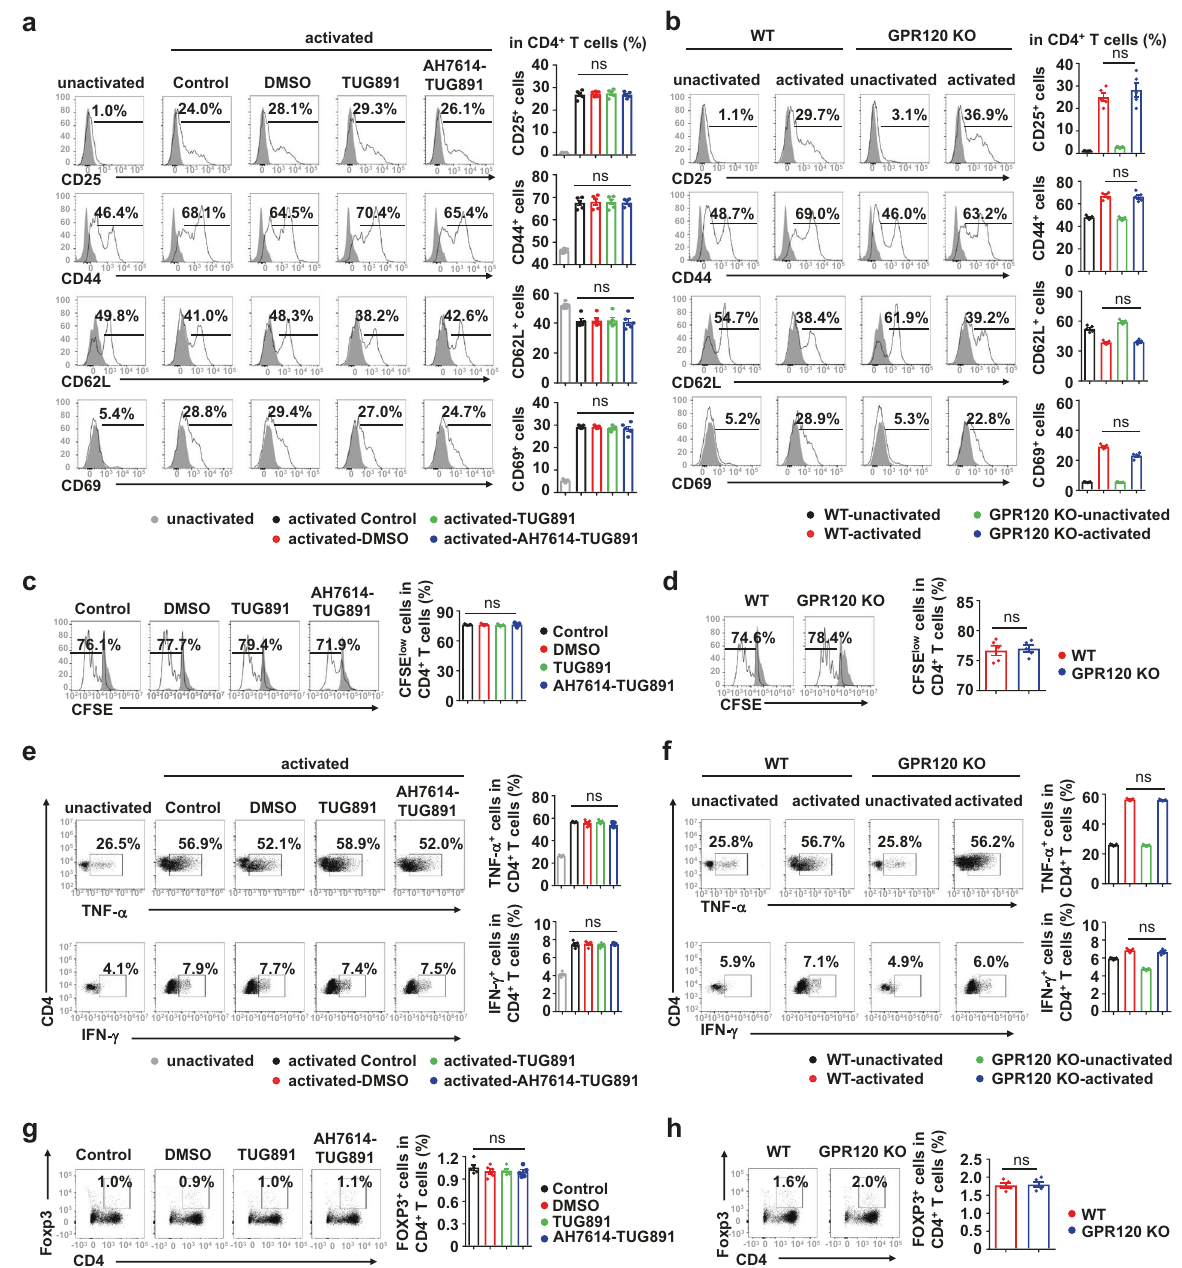
Fig. 3 GPR120 had no effects on the activation, proliferation, and differentiation of CD4 + T cells in vitro. T cells were isolated from the spleens of wild-type (WT) mice and GPR120 − / − (GPR120 KO) mice. T cells were cultured (2 × 10 5 cells/well) in the presence of anti-CD3 and anti-CD28 antibodies. T cells from WT mice were treated with DMSO, TUG891 (20 μ M) with or without AH7614 (20 μ M). a , b The expression levels of CD25, CD44, CD62L, and CD69 on CD4 + T cells were analyzed by fl ow cytometry. c , d Frequencies of the proliferating (CFSE low ) CD4 + T cell proliferation in response to the indicated treatments were measured by fl ow cytometry. e , f CD4 + T cells were stained for the surface marker CD4 and intracellular expression of TNF- α and IFN- γ on day 5 and analyzed by fl ow cytometry. g , h CD4 + T cells were stained for the surface marker CD4 and intracellular expression of Foxp3 on day 5 and analyzed by fl ow cytometry. The results are representative of three independent experiments and presented as the mean ± SEM. Signi fi cant differences were analyzed by One-way ANOVA. ns no signi fi cance.